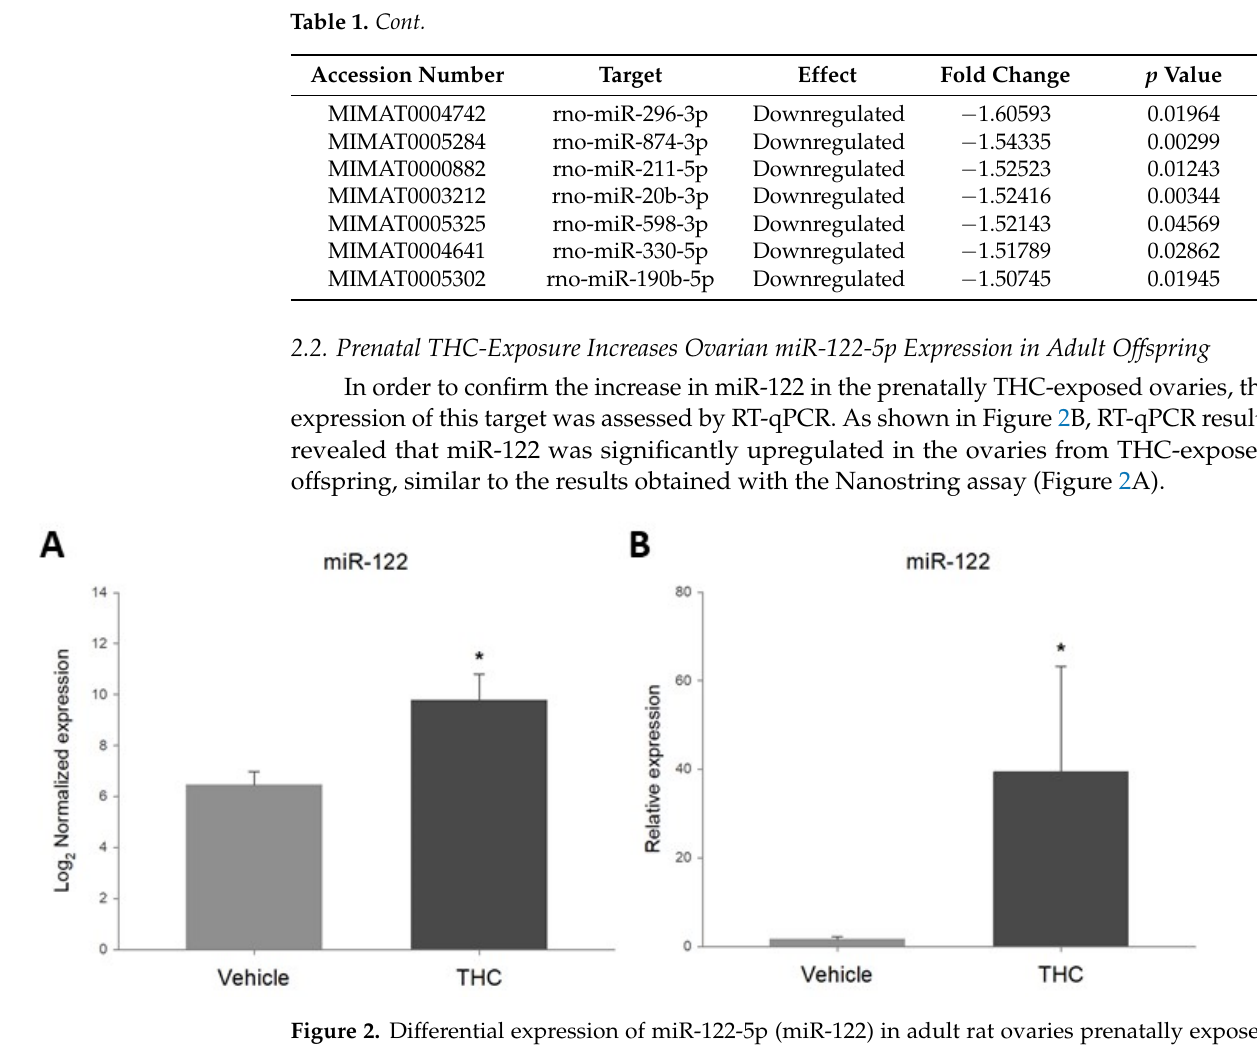
Figure 2. Differential expression of miR-122-5p (miR-122) in adult rat ovaries prenatally exposed to THC analyzed with ( A ): Rat v1.5 miRNA assay (Nanostring Technologies, Seattle, DC, USA), nSolver ® and ROSALIND ® analysis software, and ( B ): miRCURY™ LNA miRNA PCR assay system (Qiagen, Hilden, Germany) and SigmaPlot ® (mean + SEM; N = 5, * p < 0.05).